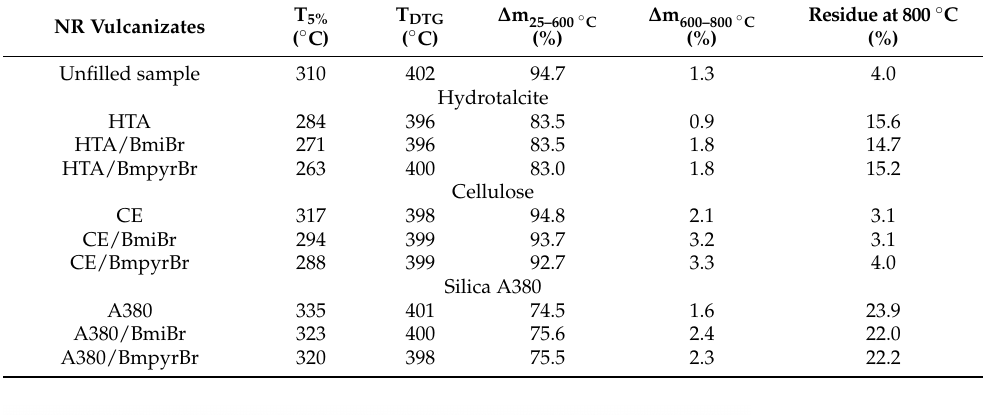
Table 9. Onset temperature of thermal decomposition (T 5% ), temperature of the DTG peak (T DTG ), and total mass loss ( ∆ m) during decomposition of NR vulcanizates (SD: T 5% ± 1.3 ◦ C; T DTG ± 1.2 ◦ C; ∆ m ± 1.3 %).